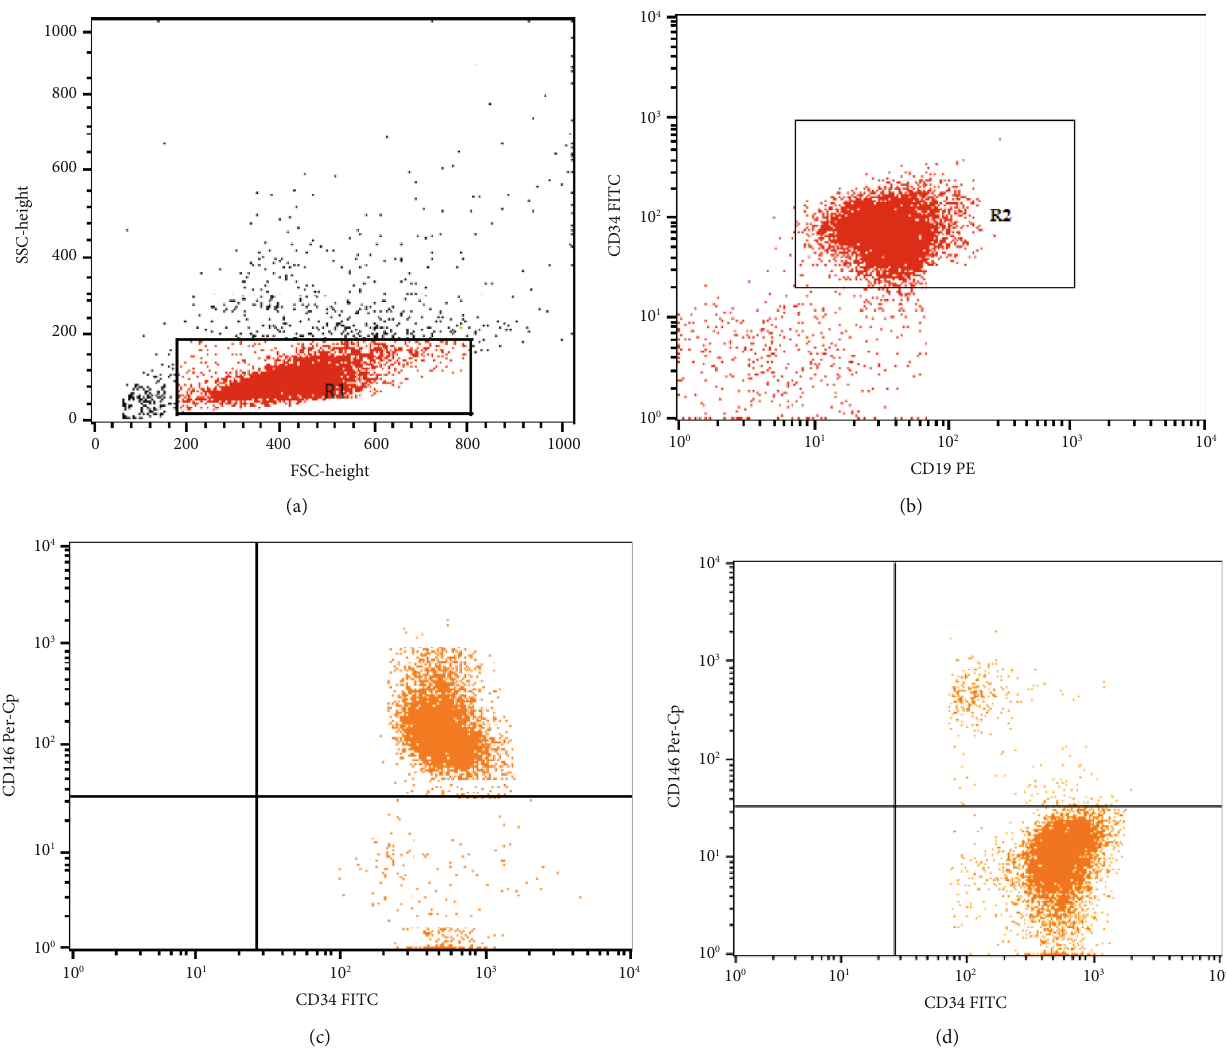
Figure 2: Flow cytometric detection of the CD146 expression on lymphoblasts. (a) Forward and side scatter histogram was used to de fi ne the blast cells (R1). (b) The expressions of CD19 and CD34 were assessed in blast cells to con fi rm lymphoblast gating which were then gated for further expression of CD146. (c) A patient with high expression of CD146 on CD19 + CD34 + lymphoblasts. (d) A patient with low expression of CD146 on CD19 + CD34 + lymphoblasts. Table 1: Clinical data of ALL